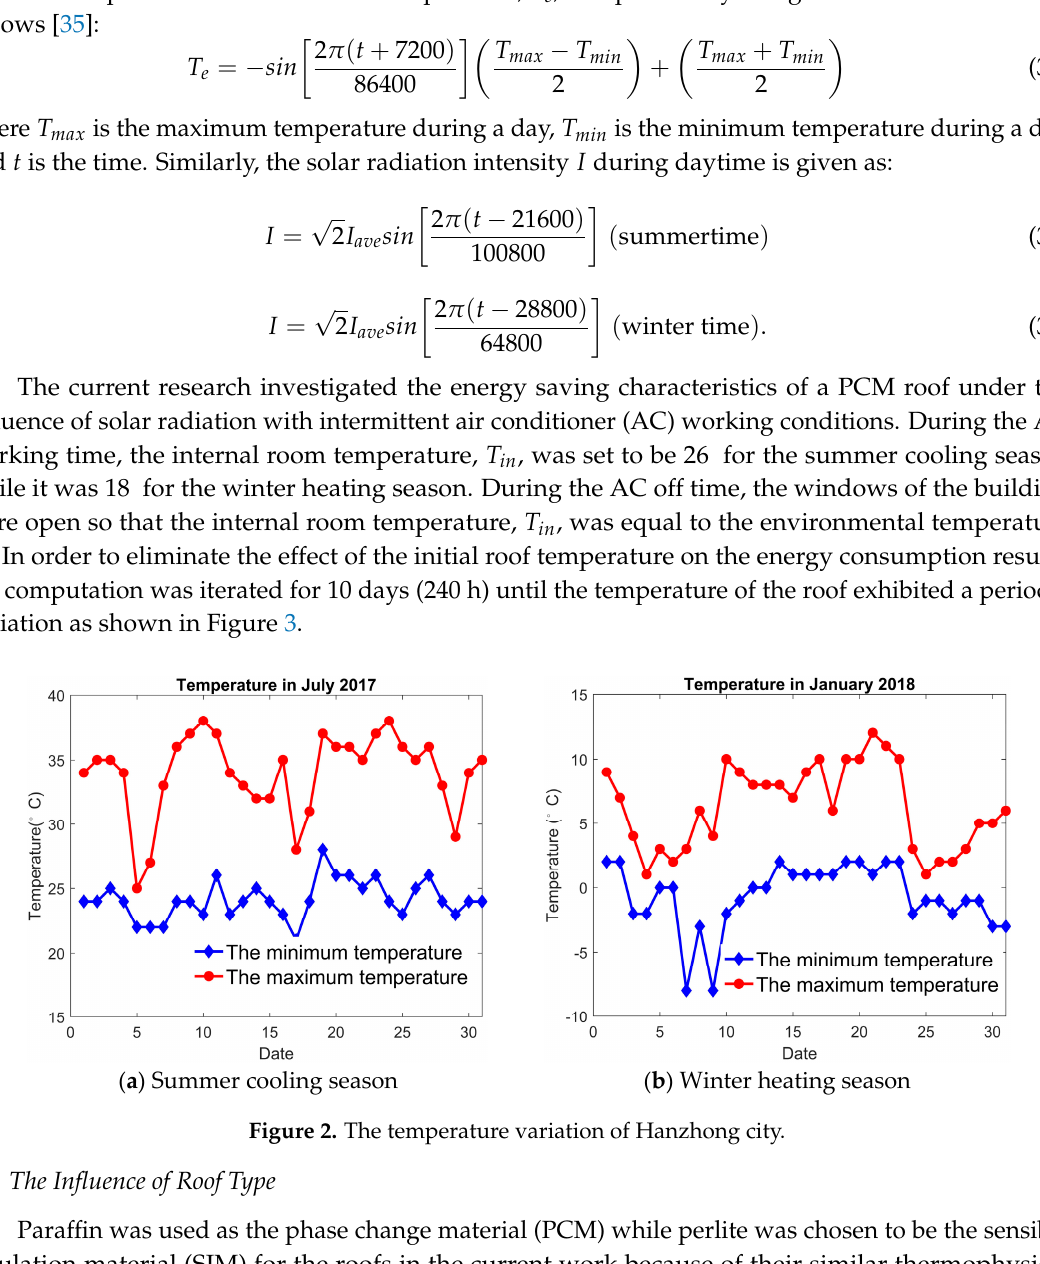
Figure 3. Iteration process of the roof temperature during the computation.